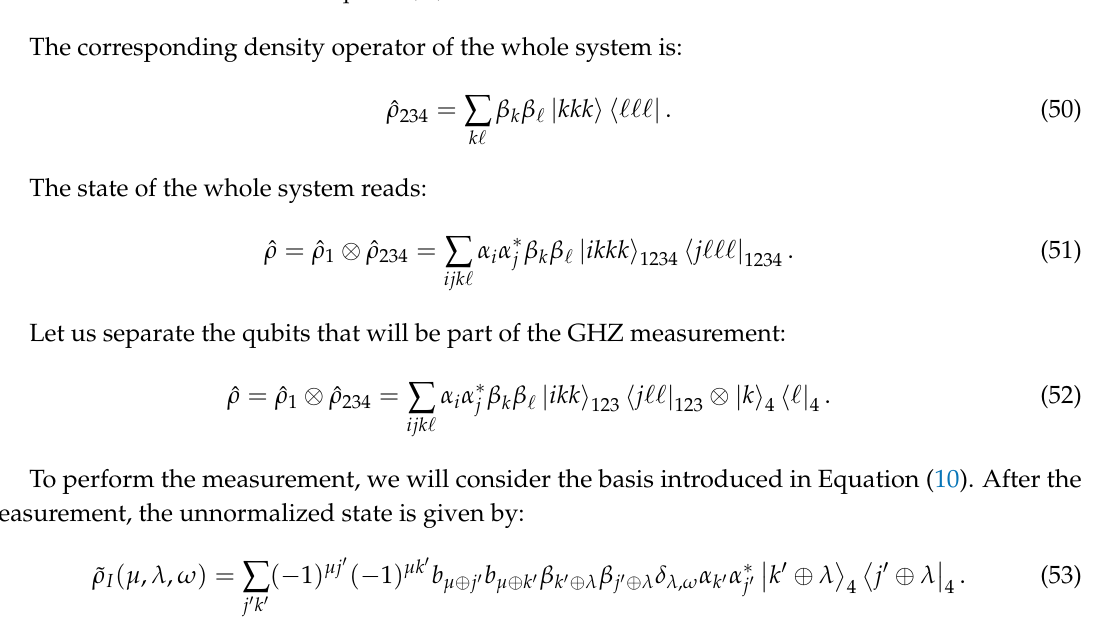
Figure 4. Scheme to teleport a single-qubit state by using a GHZ state as the quantum channel. A GHZ measurement is carried out on qubits 1, 2,